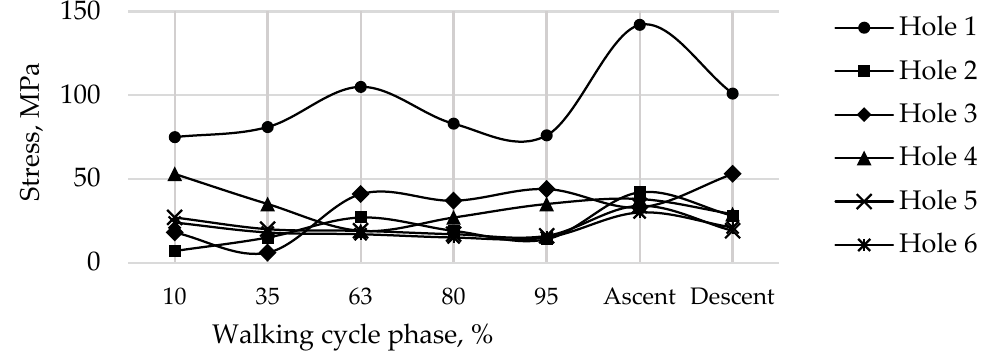
Figure 27. Maximum von Mises stress in the implant at the edges of the holes for pretension force of 50 N in different phases of the walking cycle.